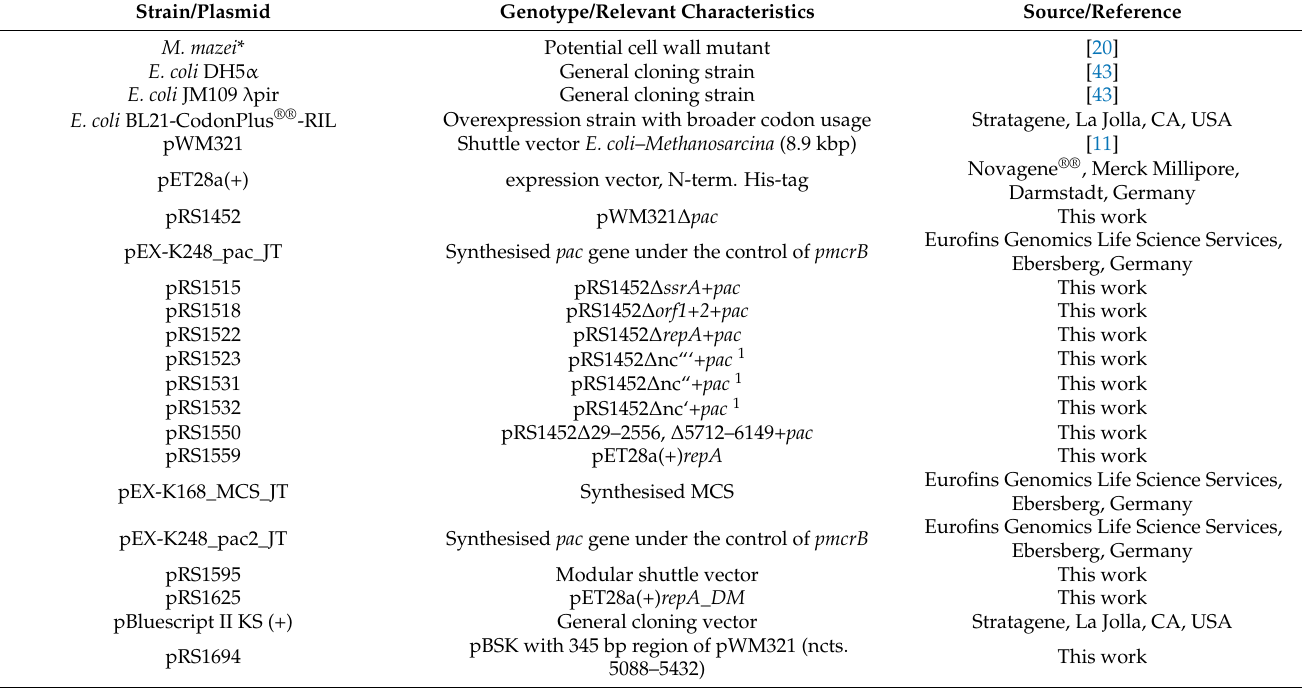
Table 2. Strains and plasmids used in this